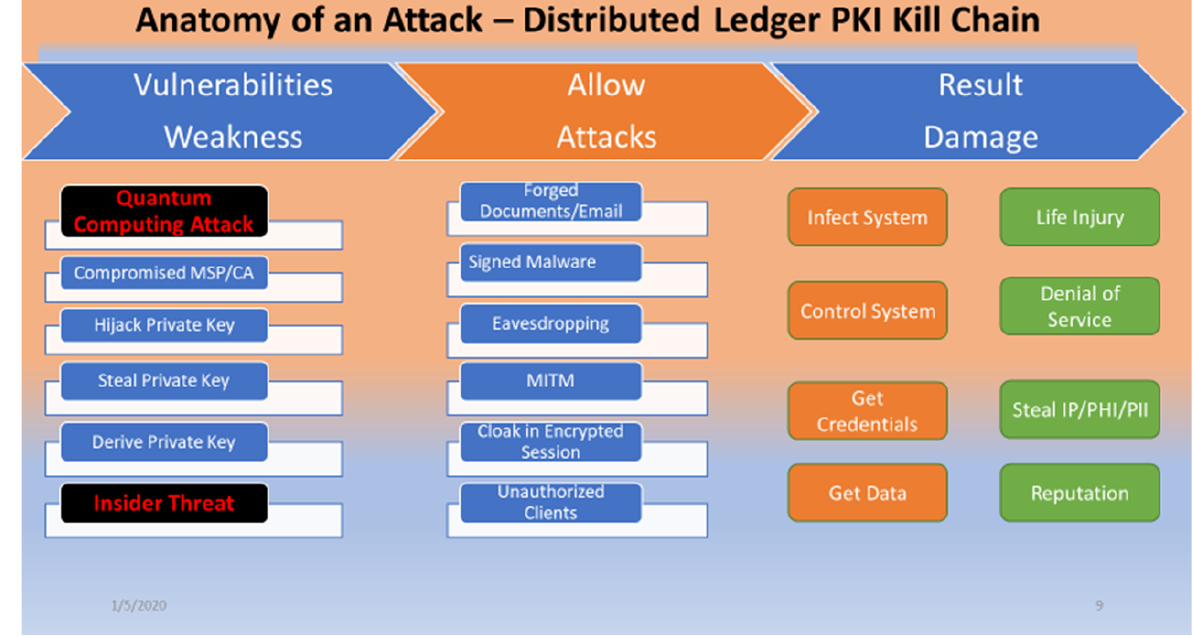
Figure 2. Distributed Ledger Kill